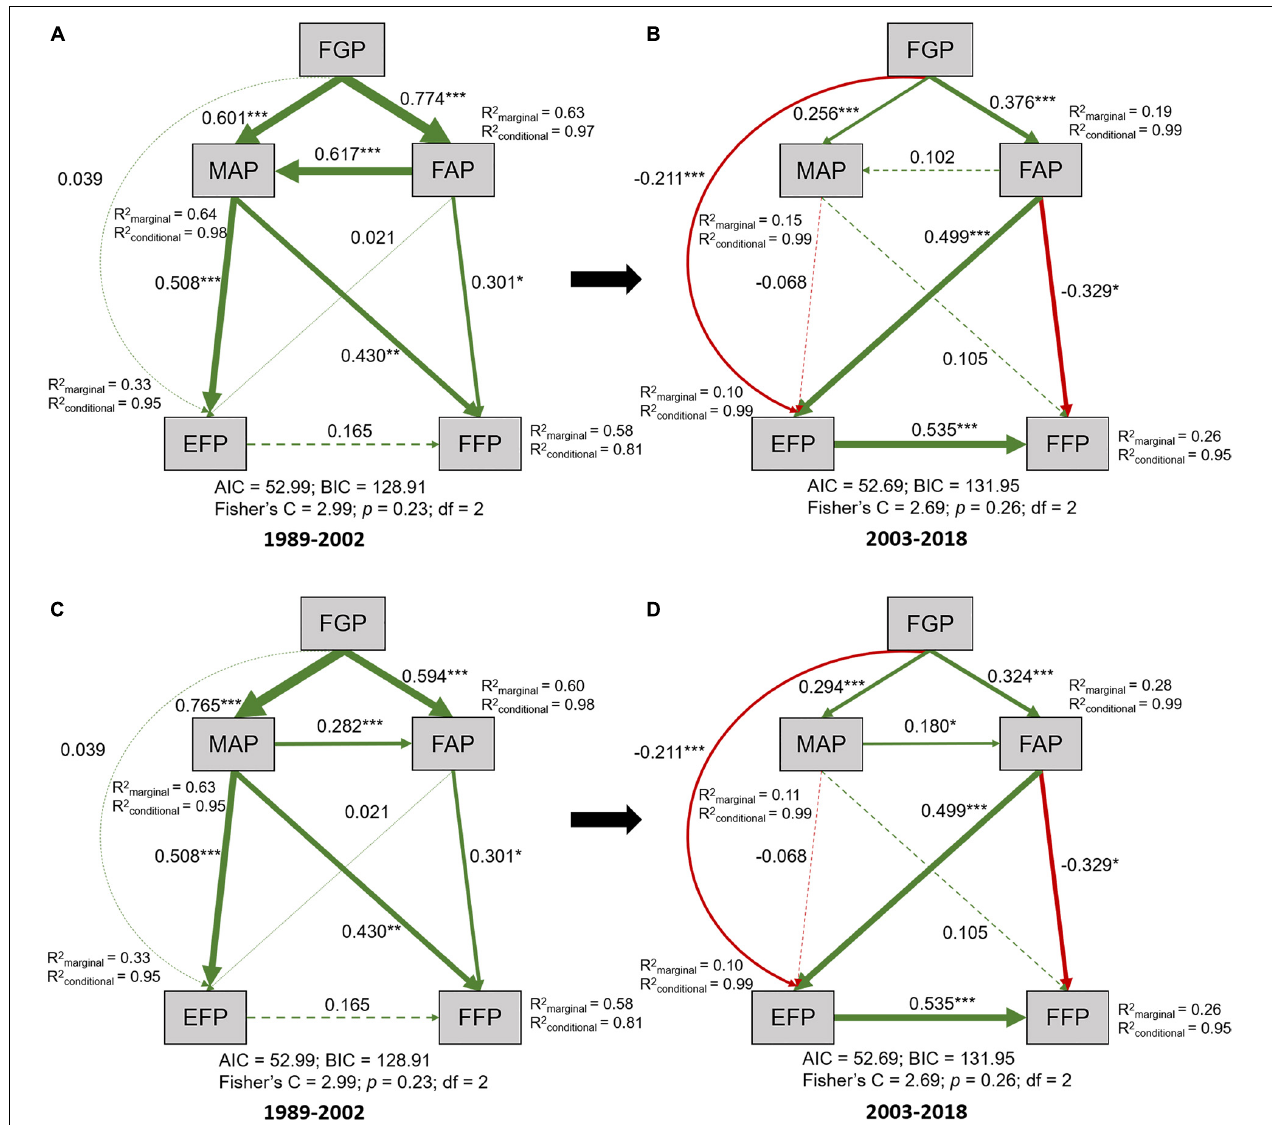
FIGURE 4 | Piecewise structural equation modeling (SEM) describing the effects of aquaculture development on marine wild fisheries in two periods. The first period was from 1989 to 2002 (A,C) and the second period was from 2003 to 2018 (B,D) . Path thicknesses have been scaled based on the magnitude of the standardized regression coefficient, which adjacent to arrows are indicative of the effect size of the relationship. Positive and negative effects among variables are depicted by green and red arrows, respectively, the dashed arrow indicate a not significant ( p > 0.05) effect. Conditional R 2 denote the proportion of variance explained by the included predictors without accounting for random effects. Marginal R 2 denotes the proportion of variance explained by the included predictors by accounting for random effects. Significance levels of each predictor are * p < 0.05; ** p < 0.01; *** p < 0.001. FGP, fishery gross product; MAP, mariculture production; FAP, freshwater aquaculture production; EFP, edible economic fish production; FFP, forage fish